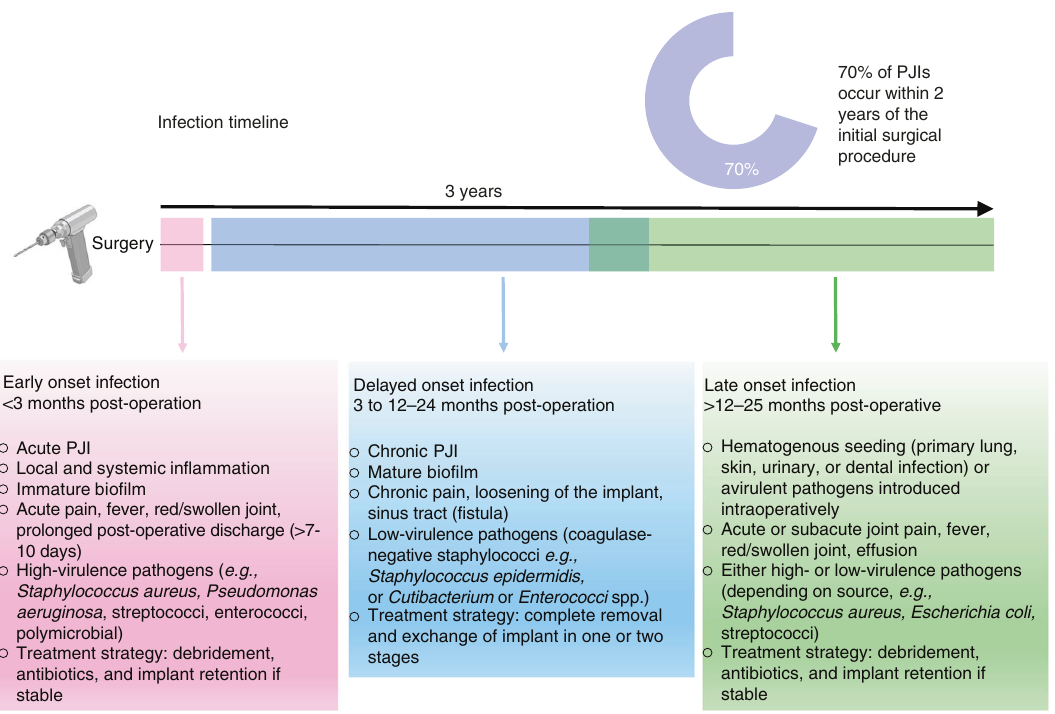
Fig. 2 S. aureus and aerobic gram-negative bacilli together contribute to ~60% of early-onset (<3 months) infections. 34 Polymicrobial infections are also higher at this time. Typically, delayed-onset PJI (3 months to 12 – 24 months postsurgery) occurs at the time of surgery and due to inoculation with less virulent microorganisms. At this stage, coagulase-negative staphylococci and enterococci are more common. Late-onset PJI (>12 to 24 months postsurgery) occurs mostly following hematogenous seeding from a primary infection located elsewhere in the body; S. aureus predominates in this situation. Late-onset PJI is less common and is often due to inoculation with relatively avirulent microorganisms